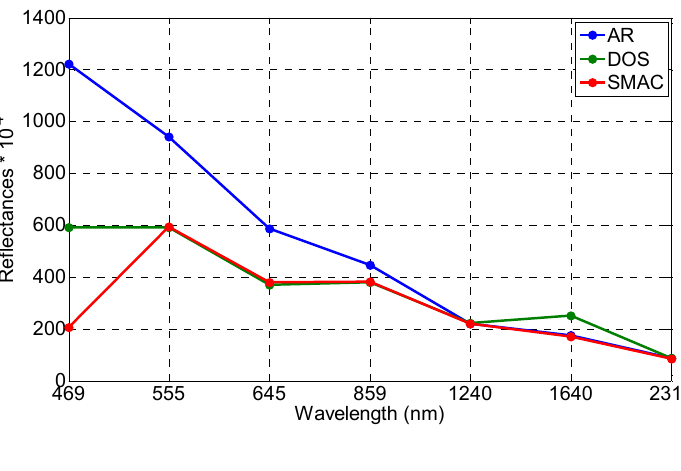
Figure 4. Comparison of the MODIS signal from Lake Champlain during an algal bloom on 19 September 2001 with different atmospheric correction